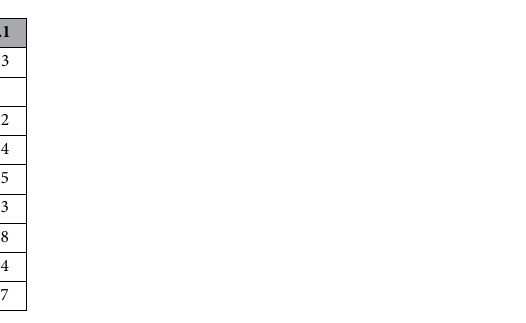
Table 7. The daily average wind speed